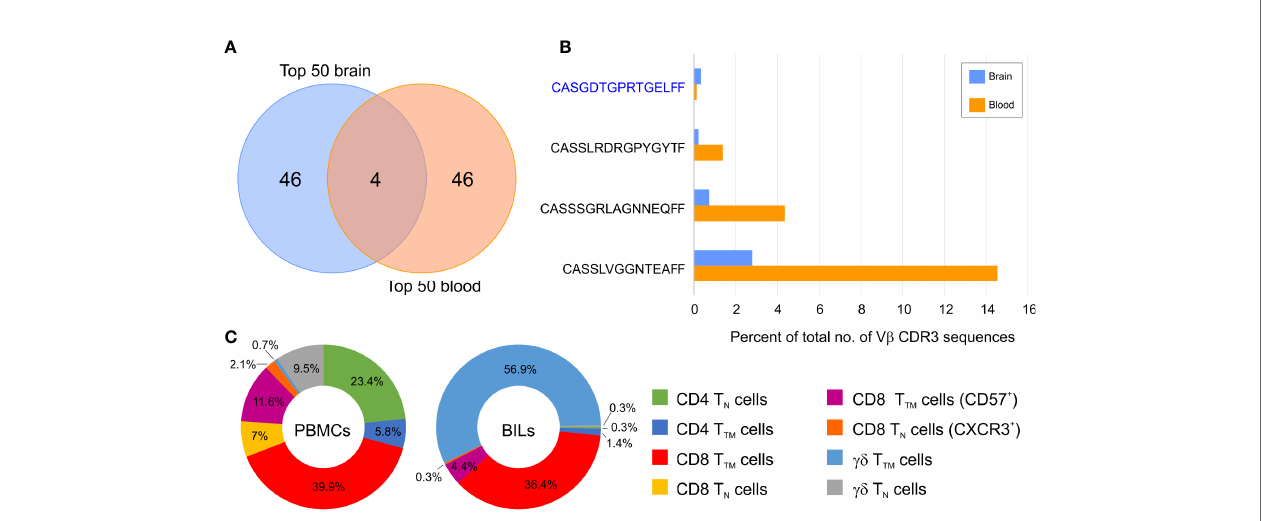
FIGURE 2 | Overlap between abundant brain and blood T cell clonotypes in a Rasmussen encephalitis patient. (A) Venn diagram showing the overlap between the top 50 brain and top 50 blood T cell clonotypes in Patient 597. (B) Relative frequency of the four overlapping T cell clonotypes in blood and brain. The private V b CDR3 amino acid sequence is in blue, public V b CDR3 sequences are in black. (C) Donut plots showing the relative frequency of T cell subsets in CD45 + CD3 + cells in peripheral mononuclear cells (PBMCs) and brain-in fi ltrating leukocytes (BILs). T N , naïve T cells; T TM, transitional memory T cells.